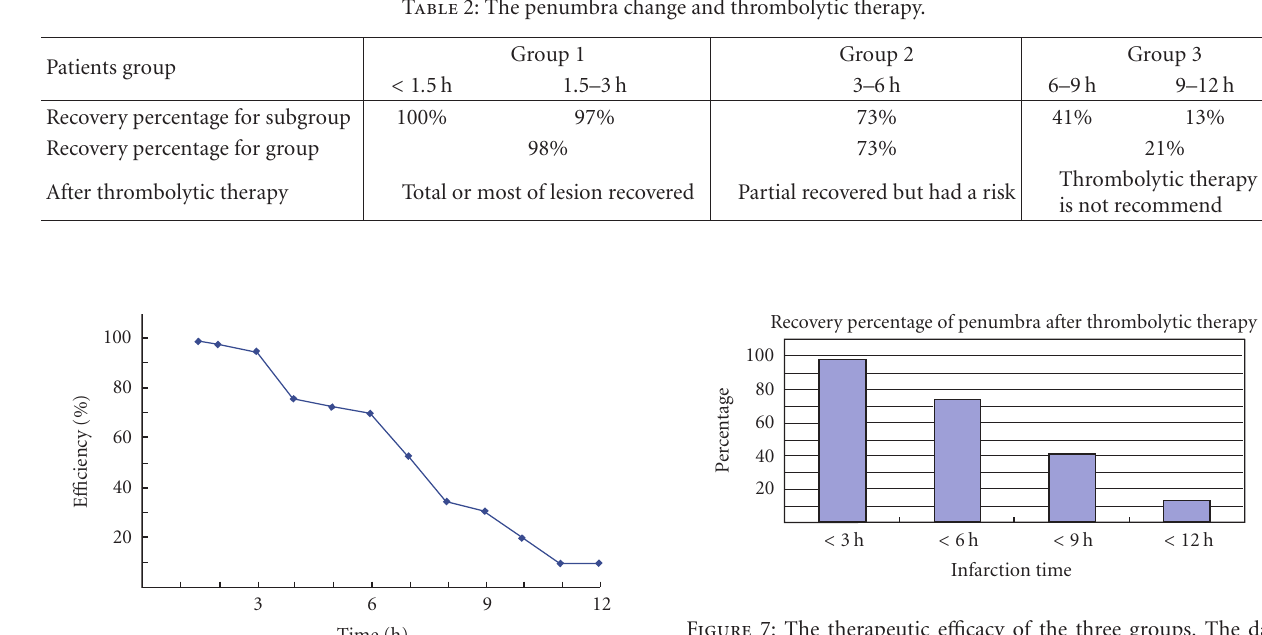
Figure 7: The therapeutic e ffi cacy of the three groups. The data were selected only the first 12 hours of infarction. The result shows that the earlier the treatment is taken, the better the therapeutic ef- ficacy is. If the thrombolytic therapy was given within 3 hours, it is very e ff ective and the most of the patients can be